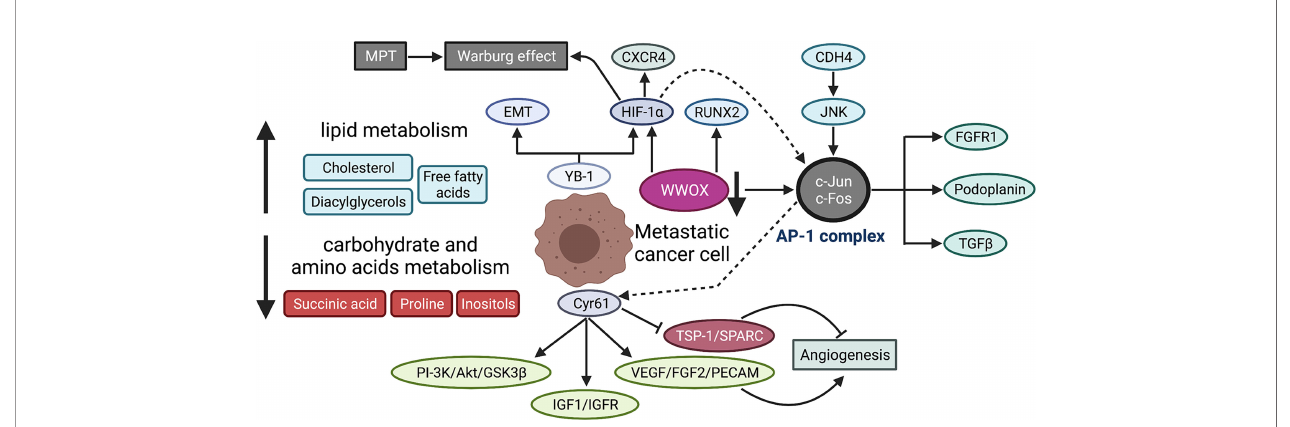
FIGURE 4 | Metabolic reprogramming during OS metastasis. MPT promotes Warburg effect in OS cells by suppressing mitochondrial function. The serum metabolic pro fi le of lung metastasis shows lowered carbohydrate and amino acid metabolism but an elevated lipid metabolism. YB-1 contributes to metastasis by translational activation of EMT and HIF-1 a , which then induces CXCR4 expression. Cyr61 enhances the metastatic potential of OS cells through multiple signaling pathways, including PI-3K/Akt/GSK3 b , IGF1/IGFR, and angiogenesis-associated signaling (increased VEGF, FGF2, PECAM and reduced TSP-1, SPARC). WWOX maintains mitochondrial respiration and inhibits Warburg effect by physical interaction with HIF-1 a . WWOX also suppresses c-Jun activity by physical association while CDH4 overexpression activates c-Jun via the JNK pathway. AP-1 is a transcriptional complex, mainly composed of c-Jun and c-Fos, which promotes metastatic potential by upregulating several downstream effectors, including FGFR1, podoplanin, and TGF b . The dotted lines indicate the mechanistic study is performed in melanoma cells, that is, HIF-1 a interacts with AP-1, which then binds to AP-1-binding motif within the Cyr61 promoter and induces Cyr61 expression. MPT, mitochondrial permeability transition; YB-1, Y-box binding protein 1; EMT, epithelial-to-mesenchymal transition; Cyr61, cysteine-rich protein 61; IGF-1, insulin-like growth factor 1; FGF2, fi broblast growth factor 2; PECAM, platelet endothelial cell adhesion molecule; TSP-1, thrombospondin-1; SPARC, secreted protein acidic and rich in cysteine; WWOX, WW domain-containing oxidoreductase; CDH4, cadherin-4; AP-1, activating protein-1; FGFR1, fi broblast growth factor receptor